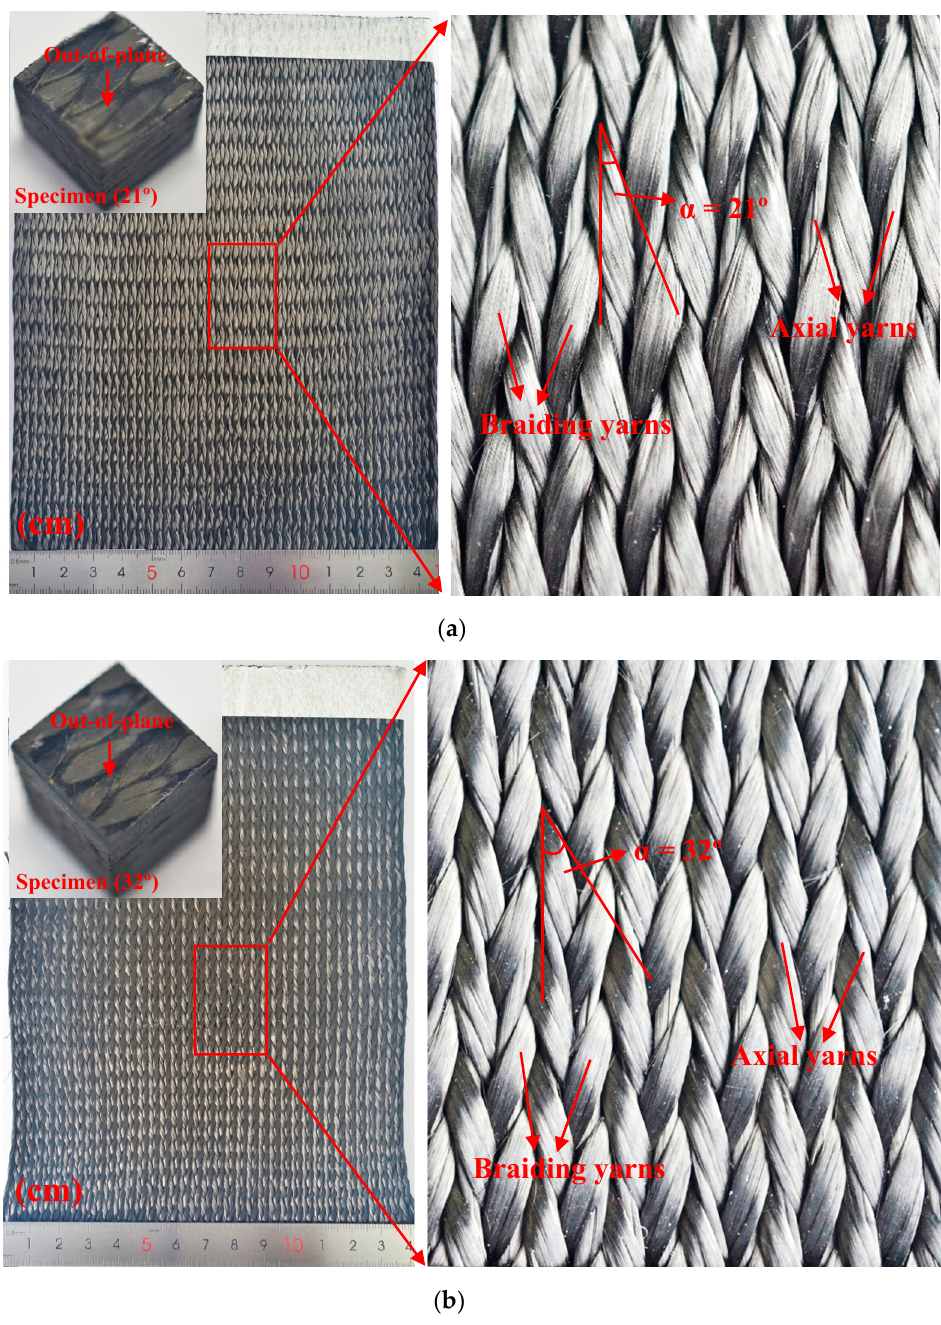
Figure 2. 3D five-directional braided preforms and composites. ( a ) Preform with 21° braiding angle and compression specimen. ( b ) Preform with 32° braiding angle and compression specimen.